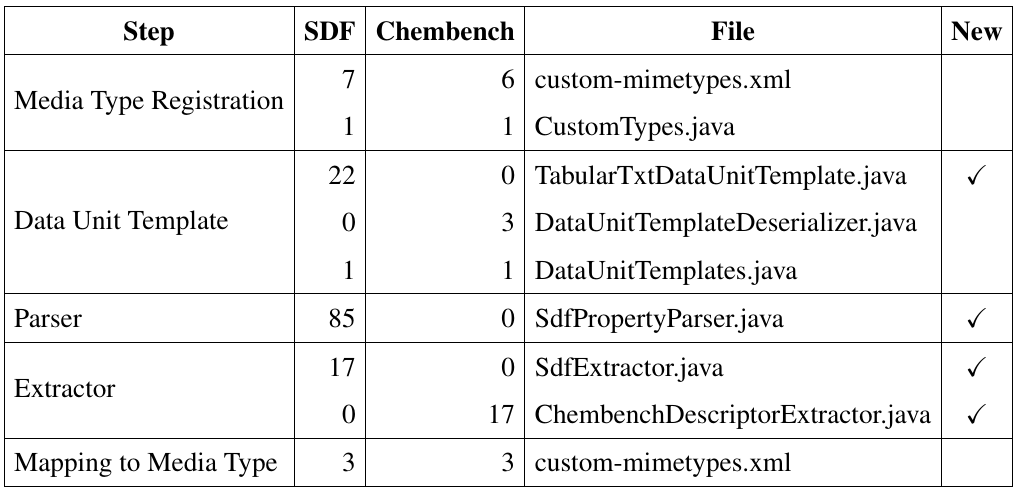
Table 1. Lines of code needed for each new file